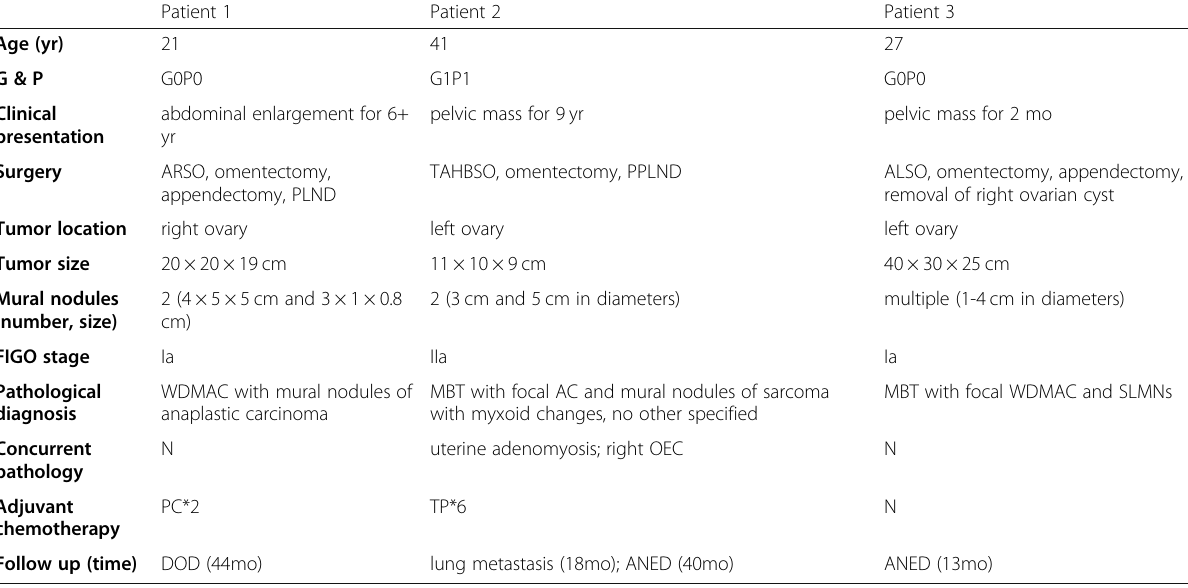
Table 1 Clinicopathological features of ovarian mucinous tumors with mural